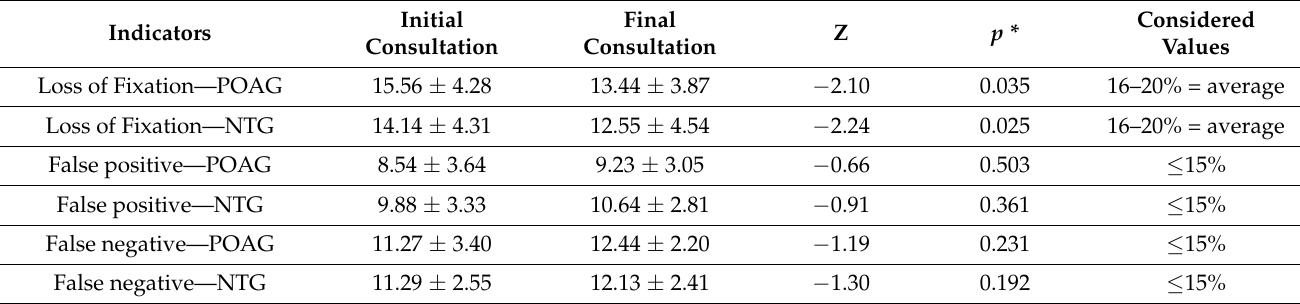
Table 5. Distribution of credibility indices in the interpretation of the “visual field”.